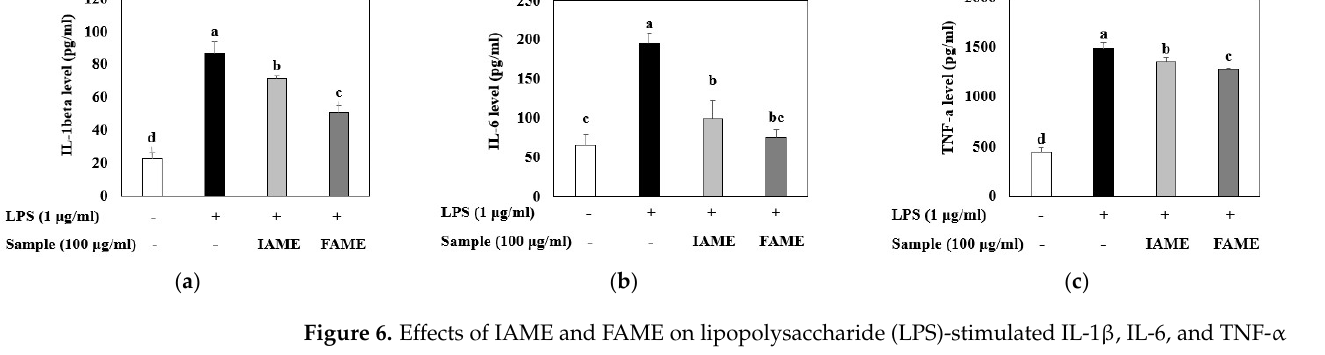
Figure 6. Effects of IAME and FAME on lipopolysaccharide (LPS)-stimulated IL-1 β , IL-6, and TNF- α release in Raw264.7 cells. Raw264.7 cells were pretreated with IAME and FAME (100 µ g/mL) for 2 h and then stimulated with LPS (1 µ g/mL) for 20 h. After incubation, the levels of ( a ) IL-1 β , ( b ) IL-6, and ( c ) TNF- α present in the supernatants were measured using ELISA kits. Each value is expressed as the mean ± SD ( n = 3). a–d Values with different letters are different at p < 0.05, as analyzed by Duncan’s multiple range test. IAME, Abelmoschus manihot extract; A. manihot extract fermented by Bacillus licheniformis CP6.